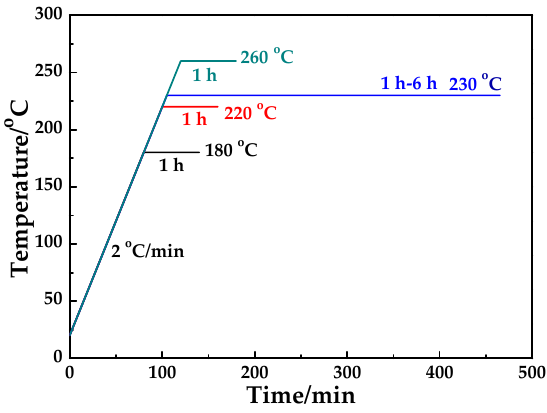
Figure 1. The cross-linking program of polyacrylonitrile (PAN) membrane.